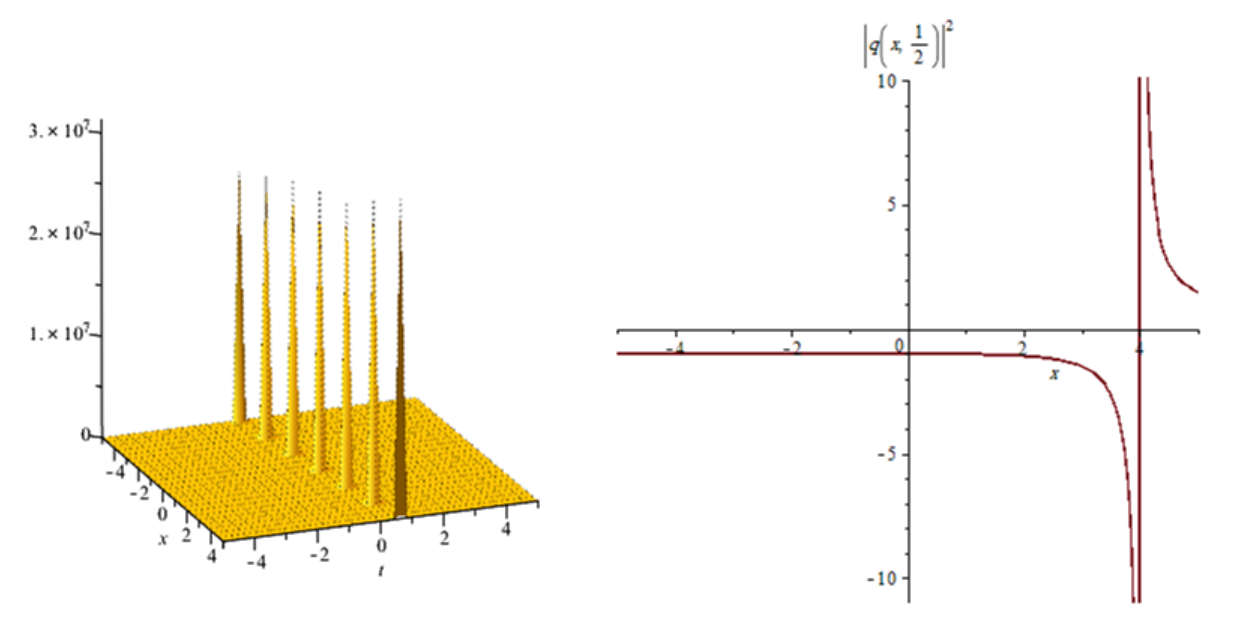
Figure 6. Shows the profile of the singular soliton solutions (19). Figure 7: The numerical simulations of the solutions (29) 3D and 2D (with t = 1 with the parameter values a 1 = 1, a 2 = 1, b = 1, σ = 0, α = 1, κ = 1 2, 5 5. c = 5, v = x , t − − ≤ ≤